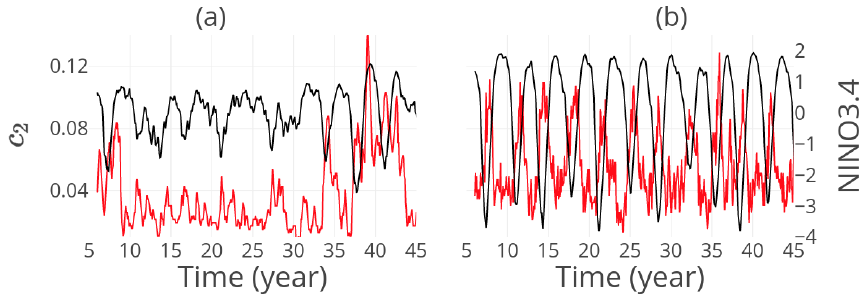
Figure 2. The network variable c 2 of the thermocline network with a sliding window of 1 year in red and NINO3.4 in black in the ZC model.